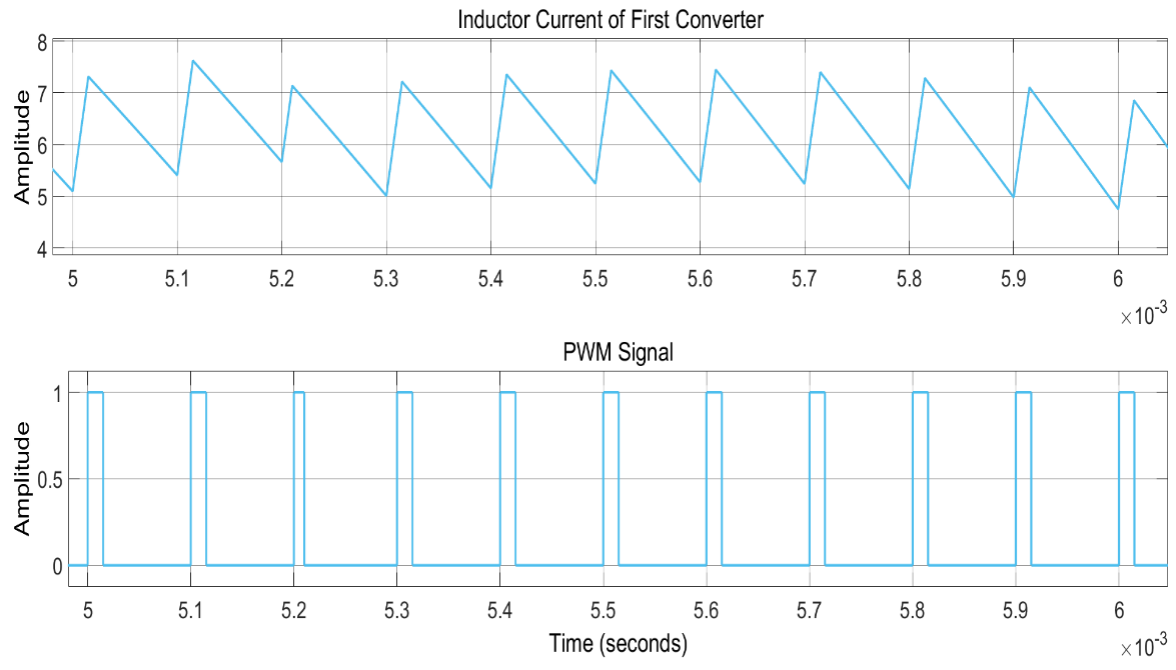
Figure 15. THD profile for proposed feed ‐ forward controller.